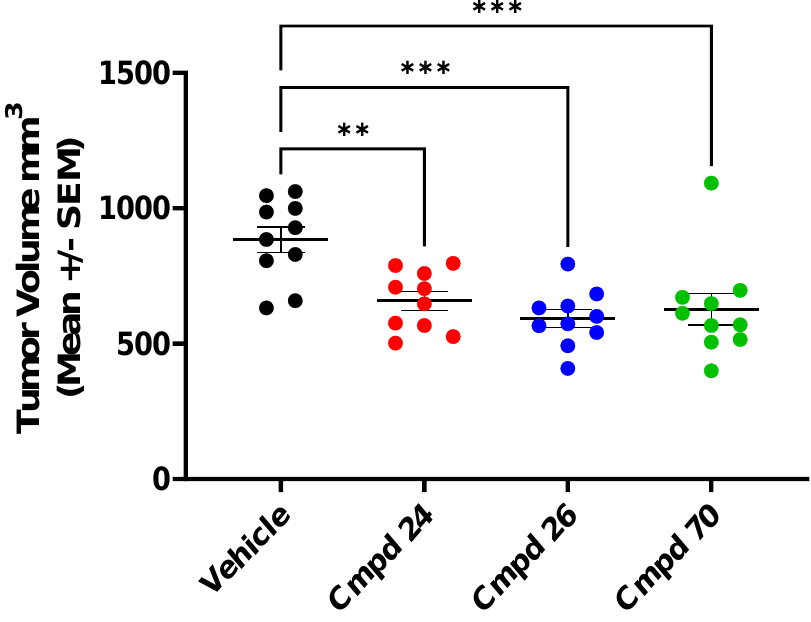
Figure 6. PERK inhibitors 24 , 26 and 70 inhibit tumor growth of 786-O RCC xenografts. Animals were treated at 30 mg/kg BID dosing for 29 days. Statistical analysis of group means by one-way ANOVA (** p < 0.01, *** p <